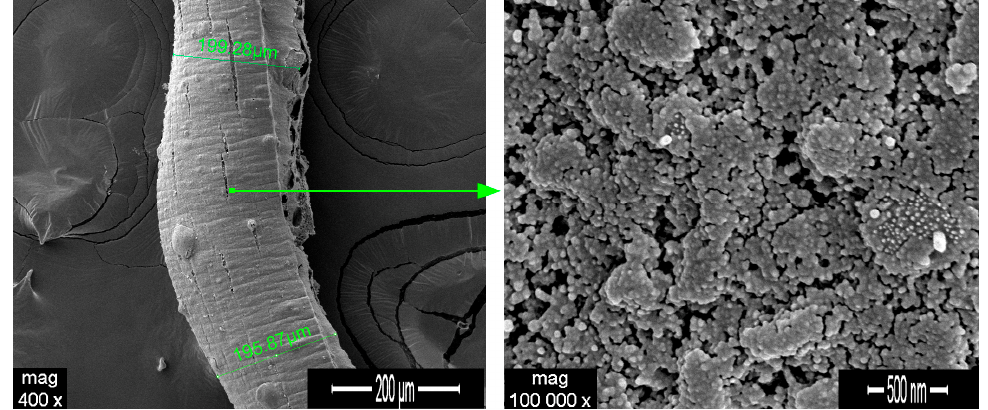
Figure 3. SEM image of the sulfonated HDPE/SKL (90:10) fiber after the carbonization process (two-stage sulfonated-carbonized).